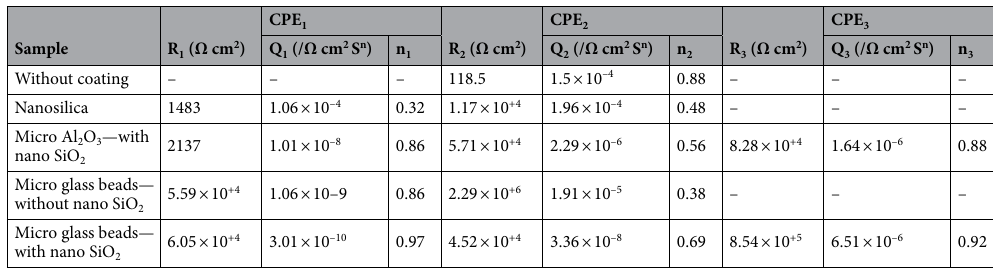
Table 5. Equivalent circuit parameters obtained by modeling the data of the coatings impedance